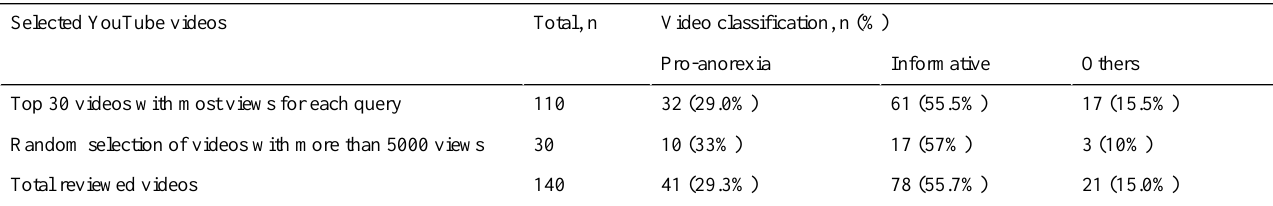
Table 1. Results of the classification of anorexia-related videos on YouTube according to the informative nature of the videos.